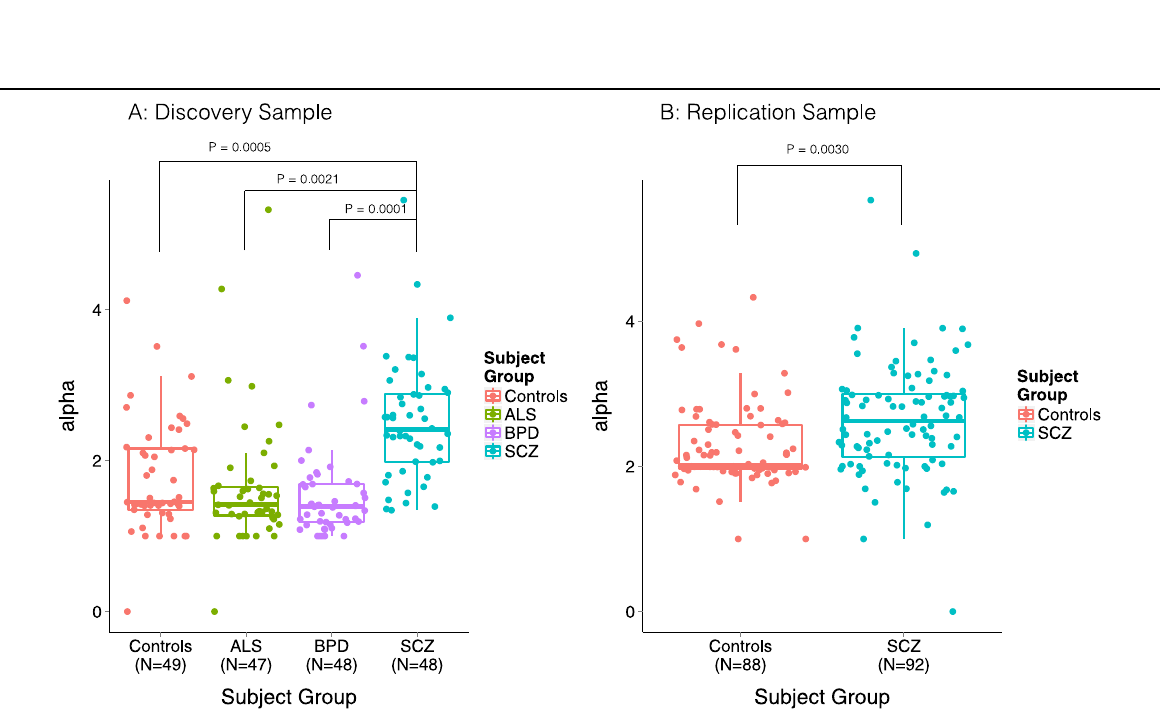
Fig. 3 Increased diversity of microbiome detected in blood in schizophrenia samples. a Alpha diversity per sample for four subject groups (Controls, ALS, BPD, SCZ) measured using the inverse Simpson index on the phylum level of classi fi cation. Schizophrenia samples show increased diversity compared to all three other groups (ANCOVA P < 0.005 for all groups, after adjustment of covariates, see also Methods, Table S5, and Figure S3). b Alpha diversity per sample of schizophrenia cases and controls, measured using the inverse Simpson index on the genus level of classi fi cation. Schizophrenia samples show increased within-subject diversity compared to Controls ( P = 0.003 after adjustment of